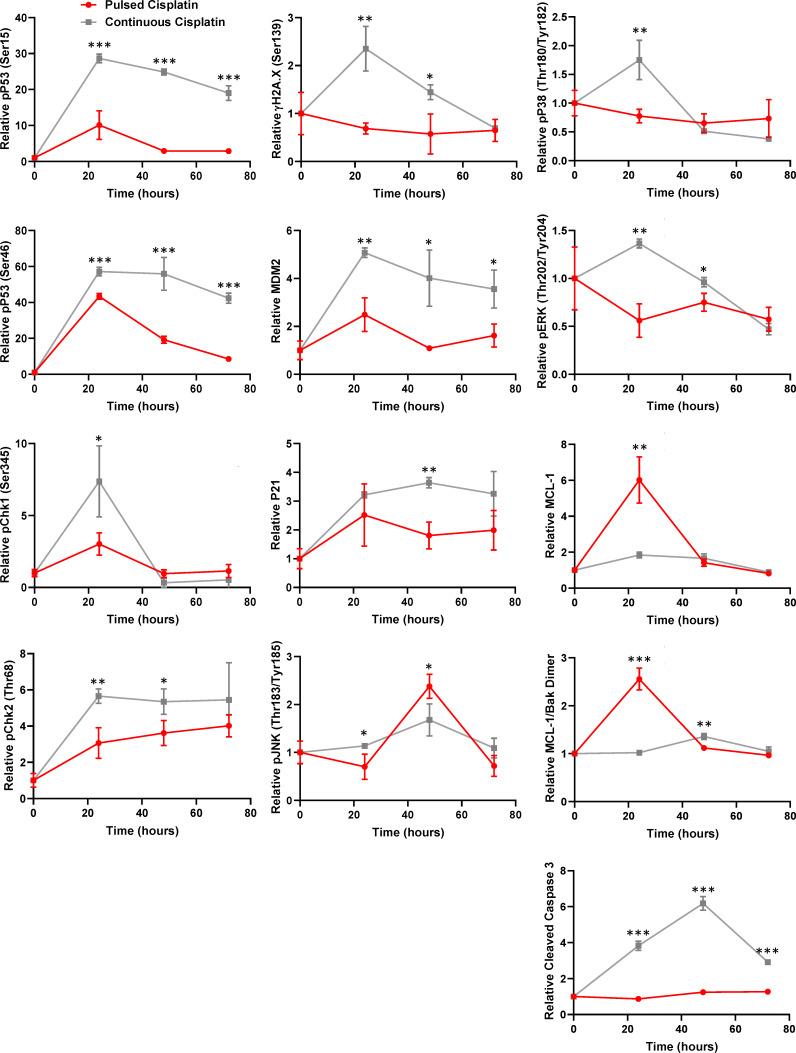
Continuous versus pulsed cisplatin treatment of A549 cells.Raw data for the timecourse, multiplex analysis of DNA damage response proteins following continuous cisplatin treatment (grey) or a cisplatin pulse (red) (5 μg/mL, 2 hr) in A549 cells. Statistical significance was determined by Student’s t-test (n = 3, mean ± SD. ***p<0.001, **p<0.01, *p<0.05).